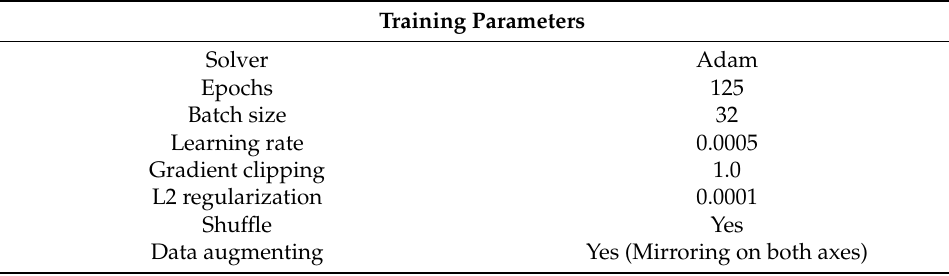
Table 15. Training parameters for UNet on